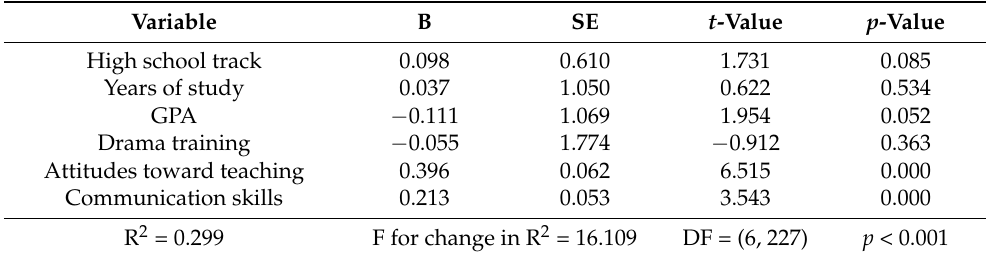
Table 2. Determinants of self-efficacy (N = 234). Variable